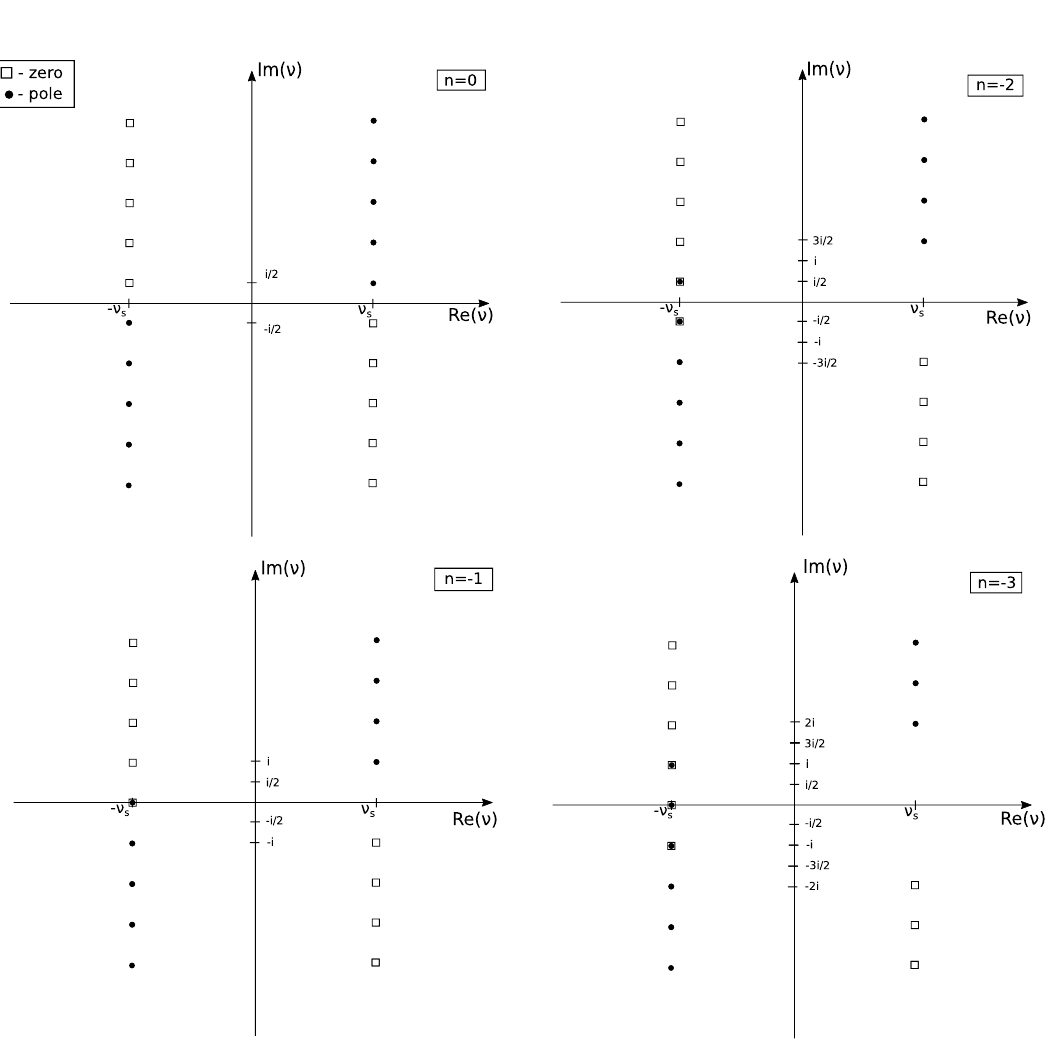
Figure 10 . Structure of poles and zeroes of the integrand in (5.2), at di(cid:11)erent values of the discrete variable n , for n s = 0. Superposition of zeroes and poles occurs in such a way that there is only one semi-in(cid:12)nite series of poles (and zeroes) in upper- and lower-